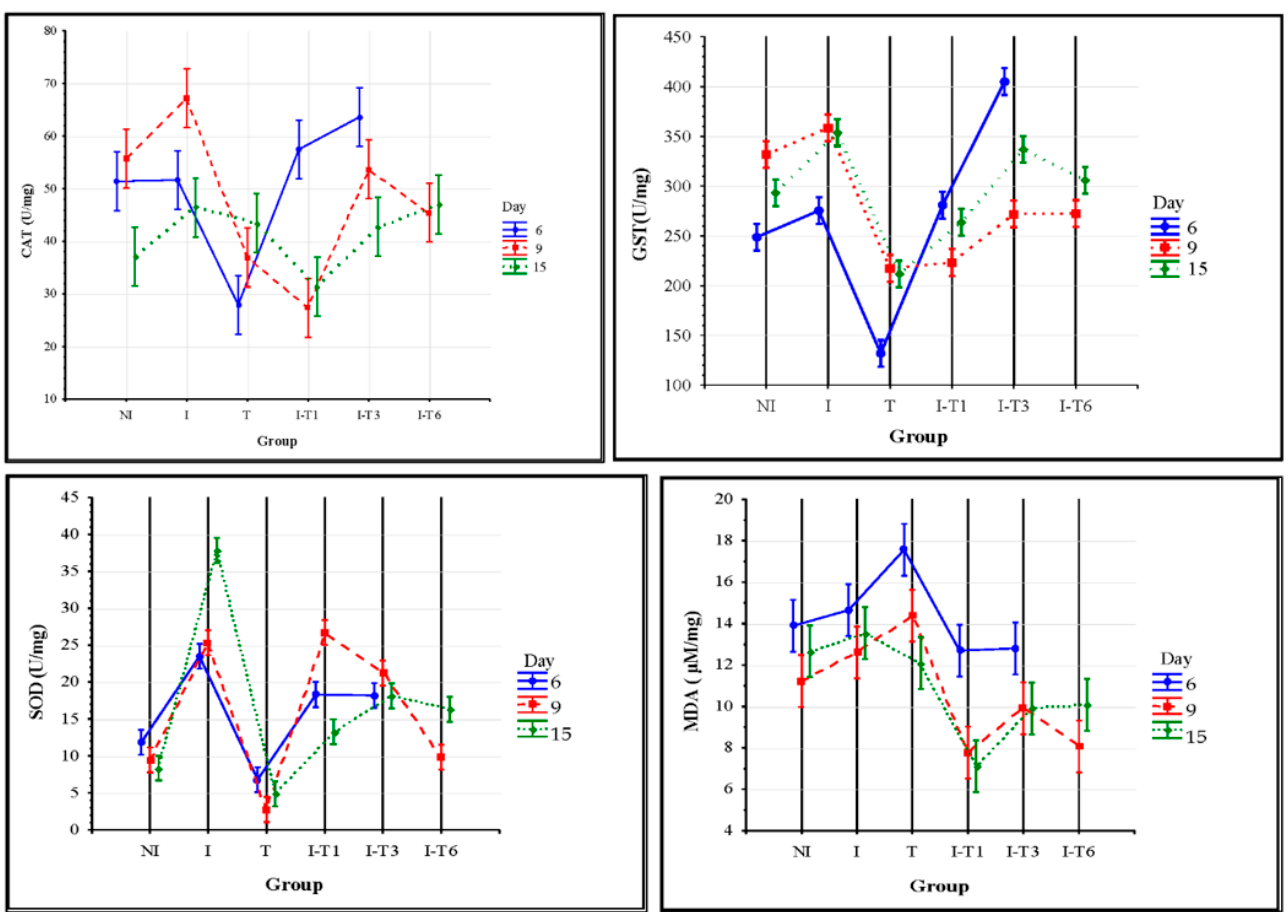
Figure 4. Activities of superoxide dismutase (SOD), catalase (CAT), and glutathione S-transferase (GST) and malondialdehyde (MDA) concentration at different time points in experimental groups. Non-infected control (NI) group, N. ceranae -infected control (I) group, thymol-treatment control group (T), and groups infected and supplemented with thymol from day 1 (I-T1), day 3 (I-T3), and day 6 (I-T6).